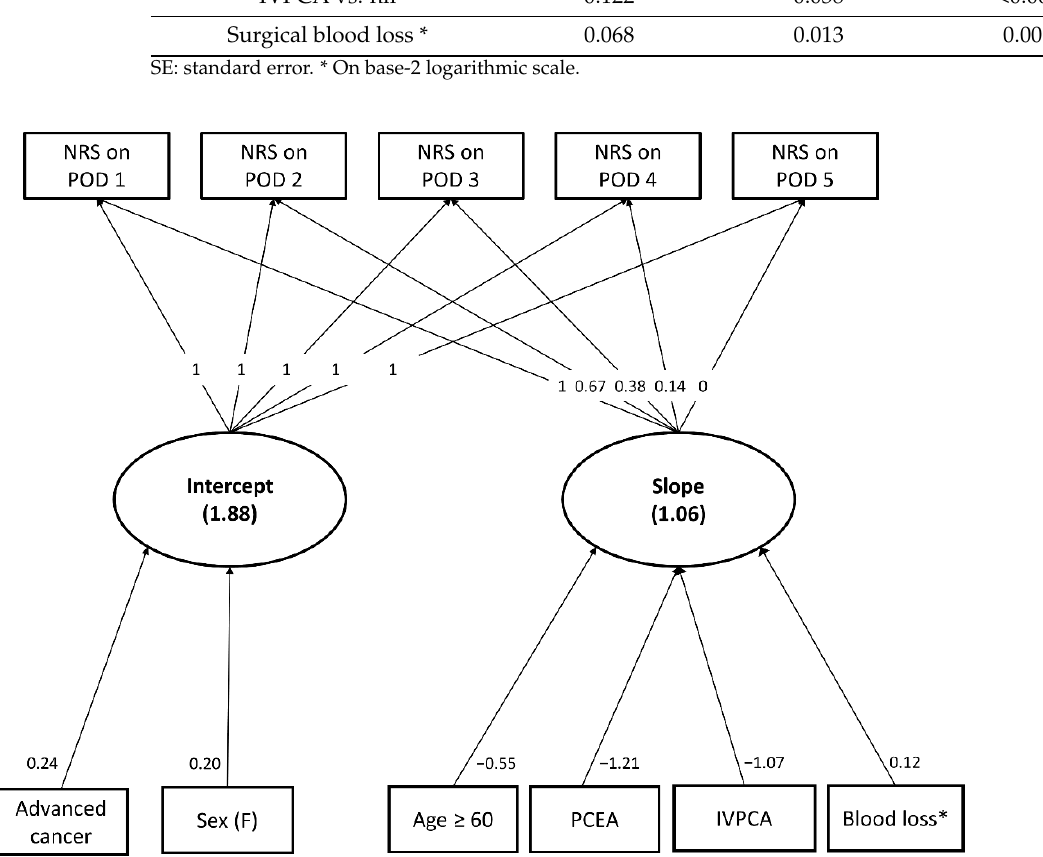
Figure 3. The final predictive model for pain trajectories after surgery for renal cell carcinoma.* On base-2 logarithmic scale.